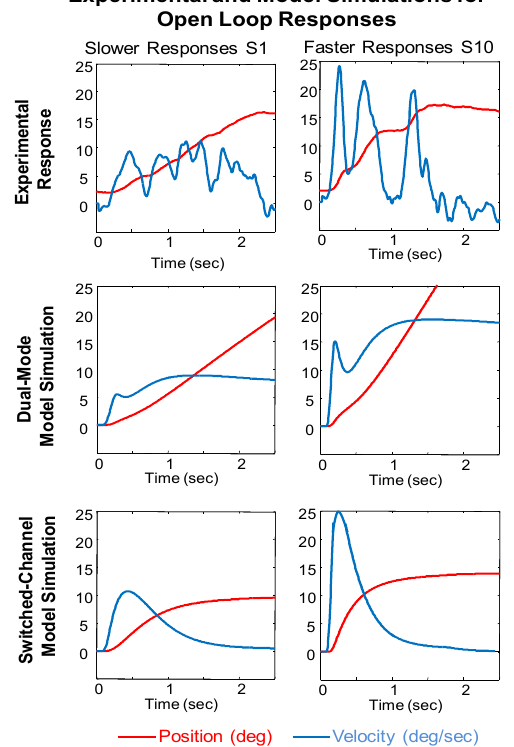
Figure 8: Open loop 2  experiment. Experimental responses (upper plots), dual-mode model simulations (middle plots) and switched-channel model simulations for response from subject S1 who has slower vergence dynamics (left plots) and from subject S10 who has faster vergence dynamics (right plots). The models used the plant proposed by Robinson. Position is plotted in red and velocity is plotted in